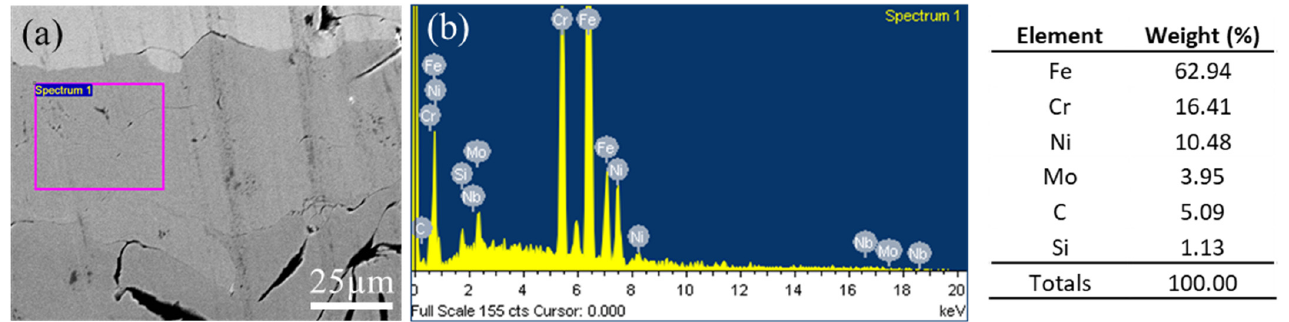
Figure 5. ( a ) EDS scanned region and ( b ) elemental composition (wt.%) of the bond coat on the as-sprayed coating.